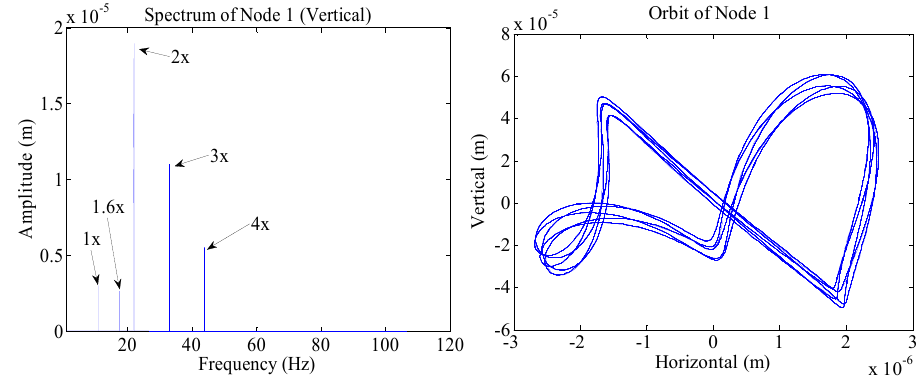
Figure 15. The spectrum and the orbit of Bearing 1 (equal weight coefficients).